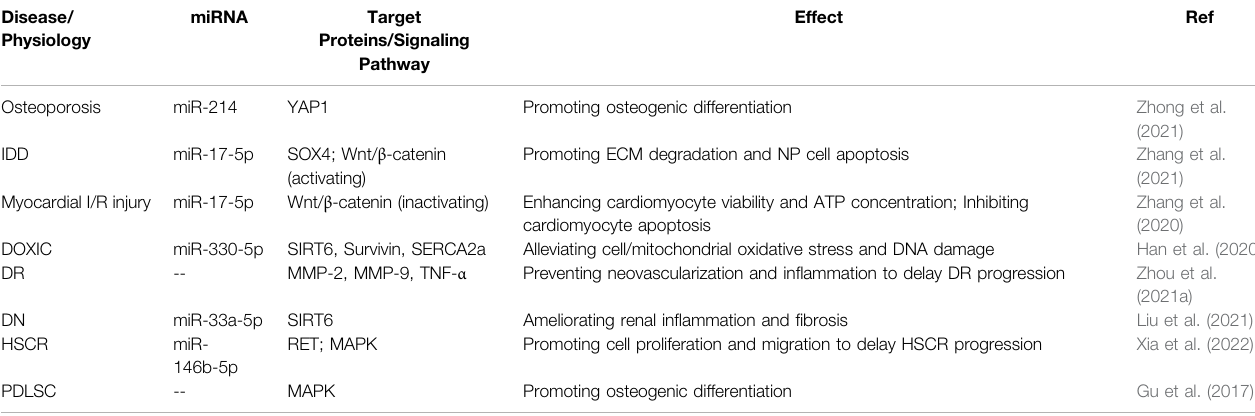
TABLE 2 | Role and mechanism of circ-ITCH in non-tumor diseases and physiology. Disease/ Physiology